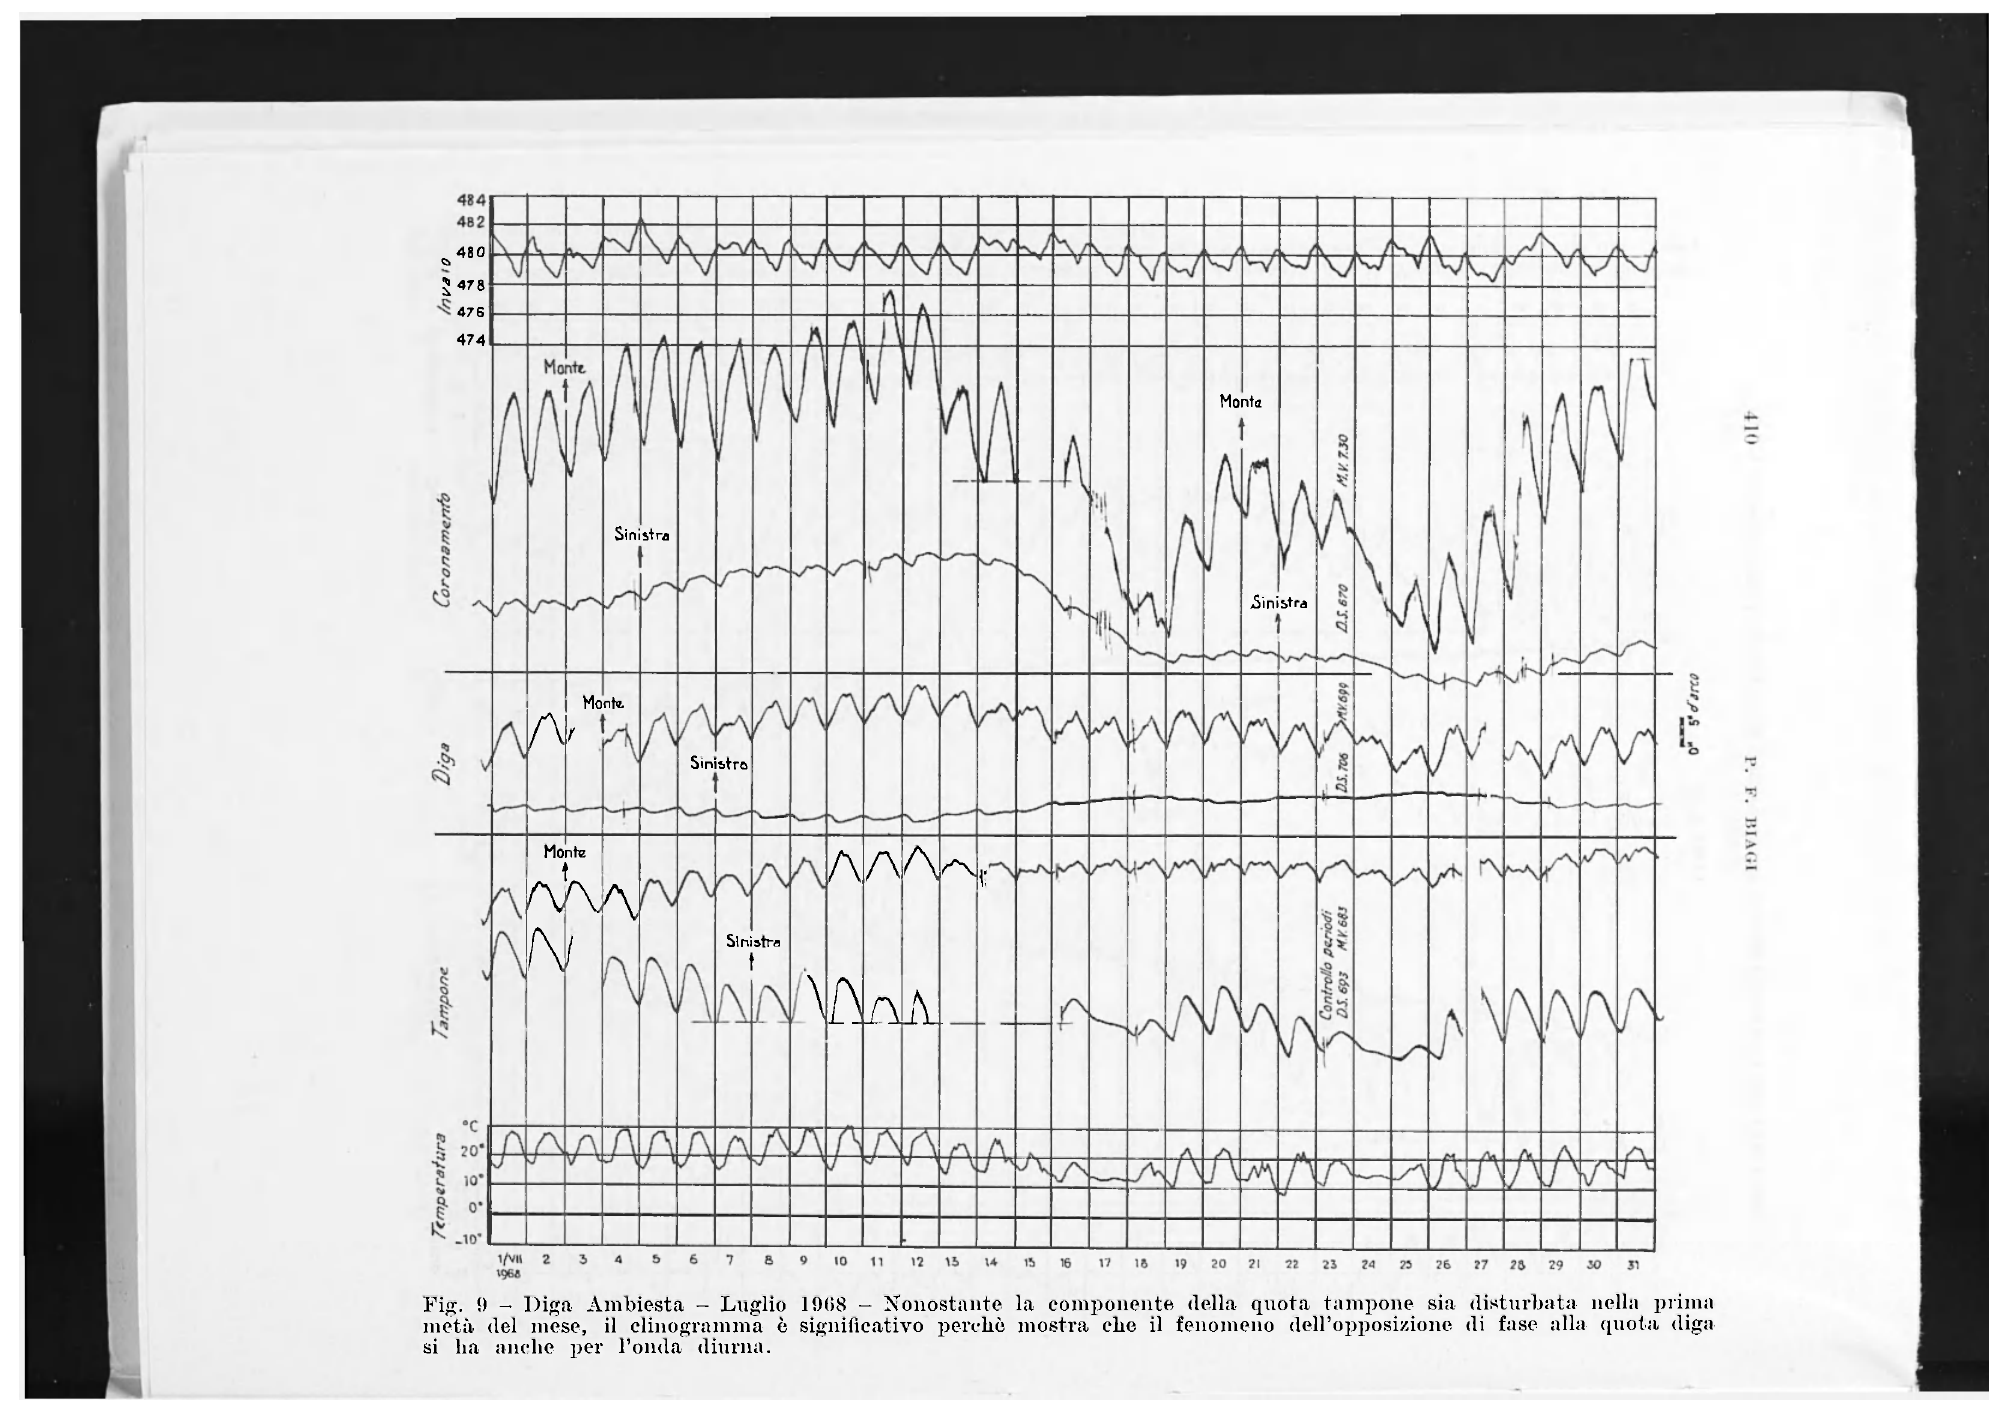
Fig. 9 - Diga Ambiesta - Luglio 1968 - Nonostante la componente della quota tampone sia disturbata nella prima metà del mese, il clinogramma è significativo perchè mostra che il fenomeno dell'opposizione di fase alla quota